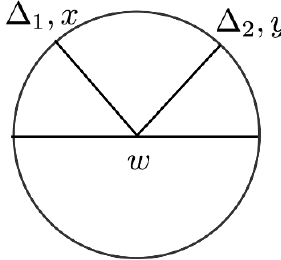
Figure 3. A contact Witten diagram W contact in the probe brane setup. The disk represent AdS d +1 space and the horizontal line represent the AdS d interface.